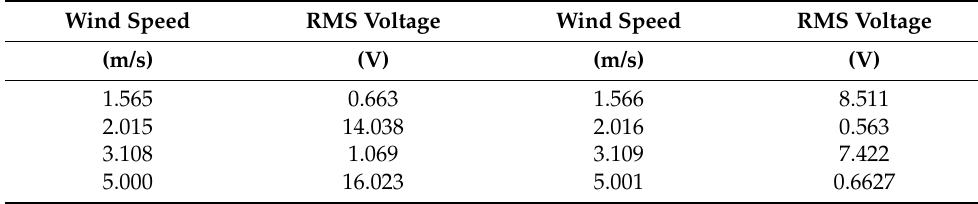
Figure 8. Root-mean-square (RMS) voltage versus wind speed. Table 2. RMS voltage at several typical wind speeds.